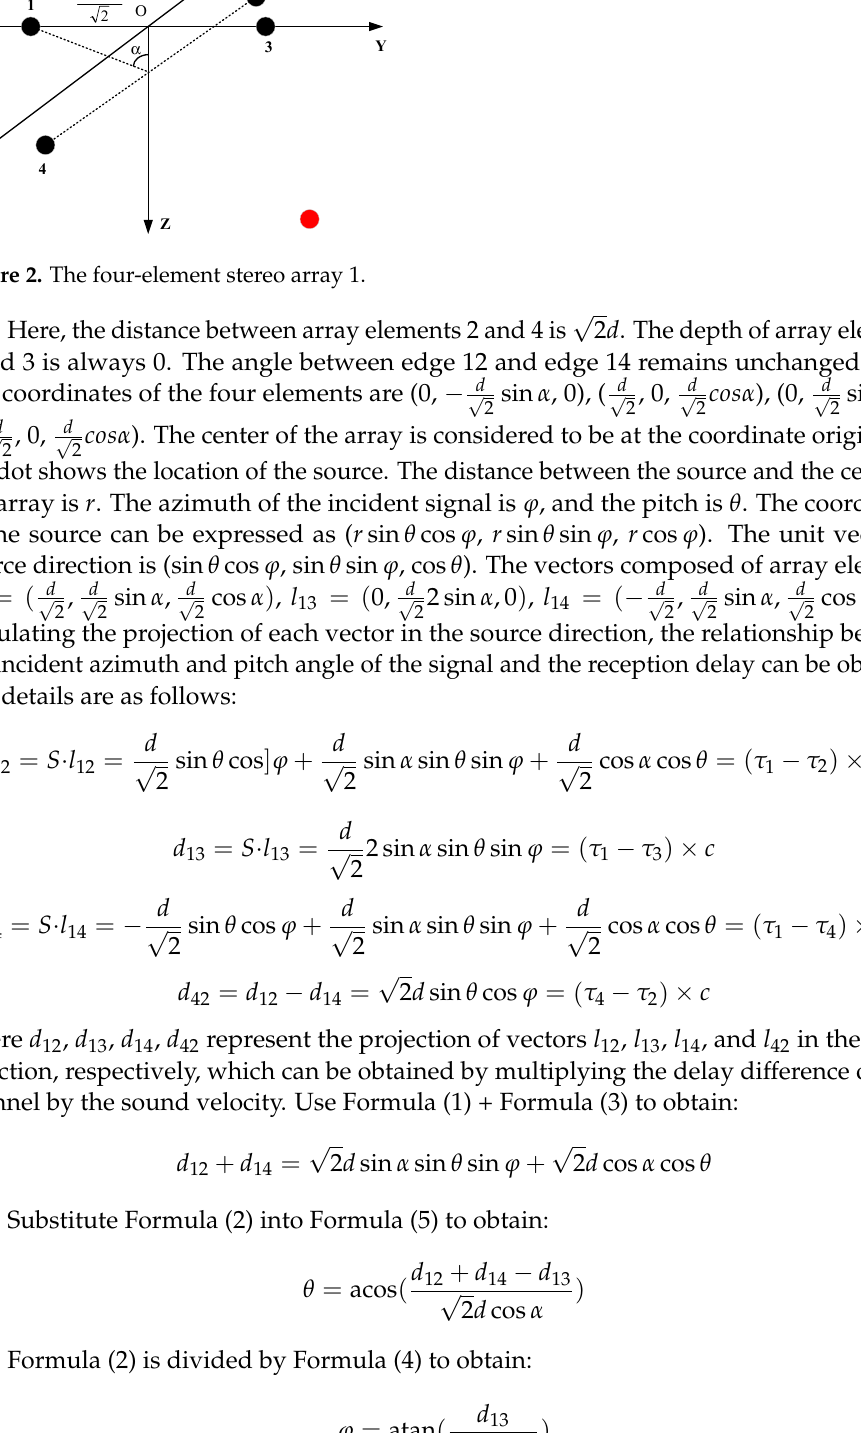
Figure 1. Traditional four-element planar array.